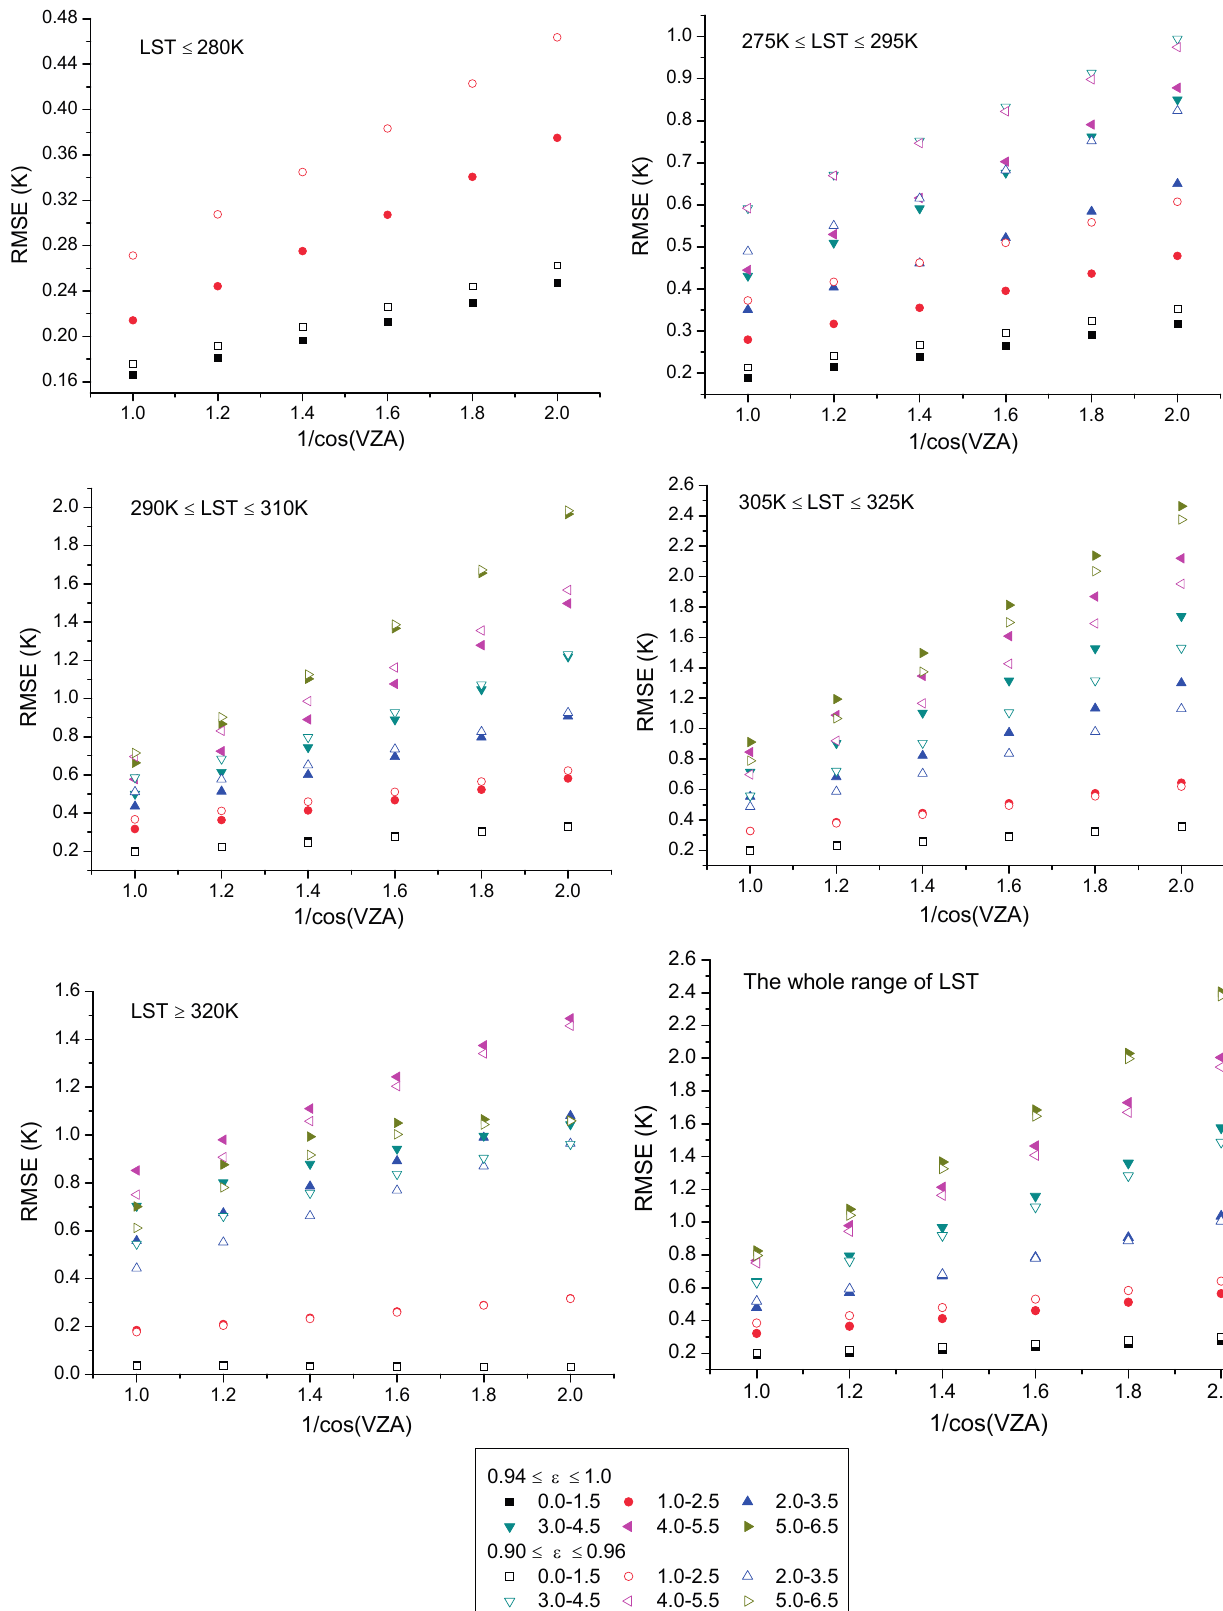
Figure 8. RMSEs between the actual and estimated (cid:1846) various sub-ranges in two emissivity